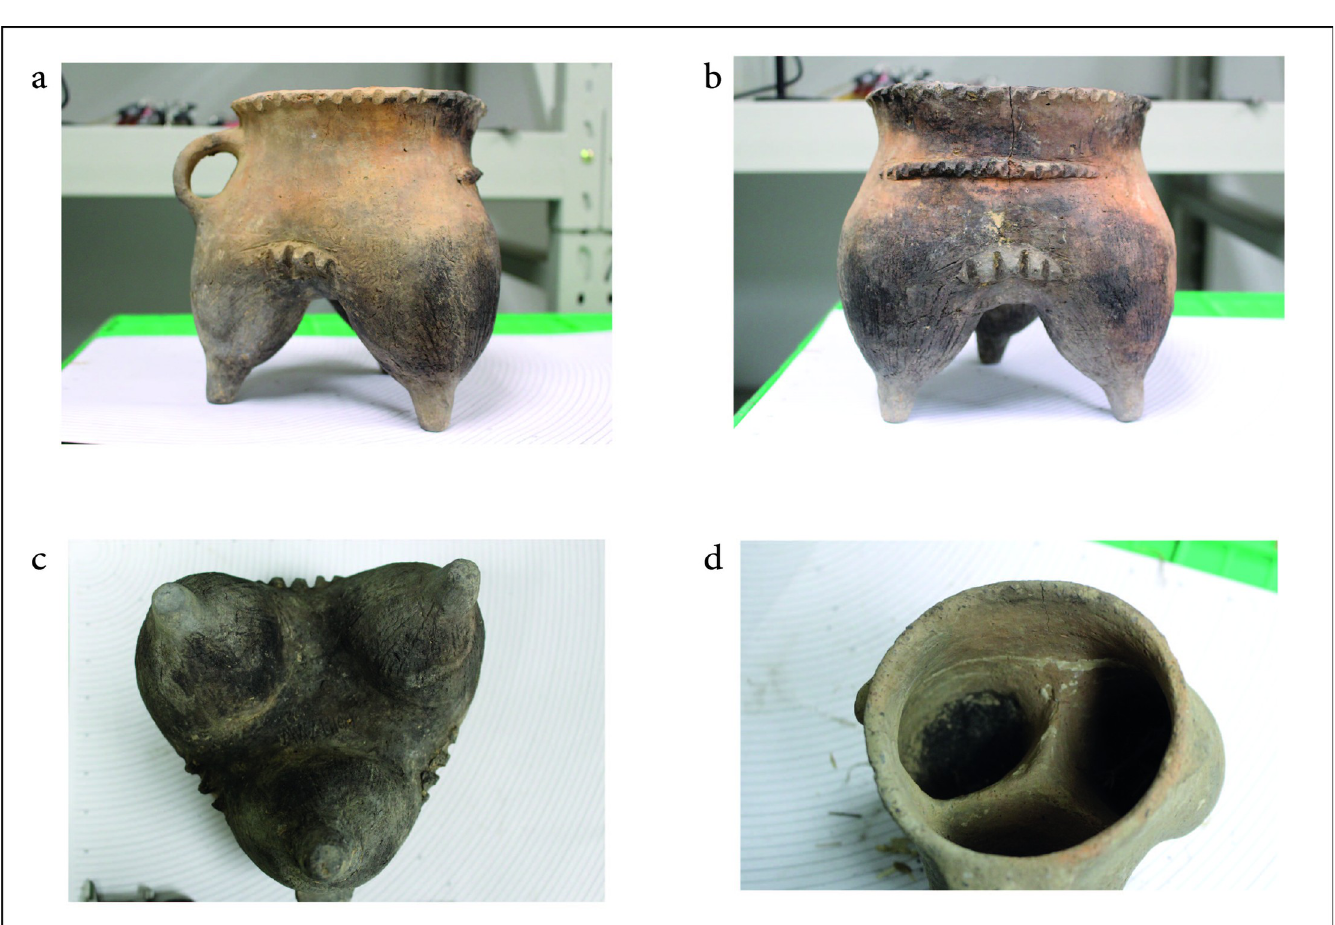
Fig 5. Use-wear alteration marks of Zhanqi li vessels. A. Soot remains extending from the belly down to the foot. B. Soot remains on the handle perpendicular to the side exposed to the fire. C. Heavy sooting on the base and oxidation on the feet (nipple), indicating placement base side down in the fire. D. Heavy carbonization can be seen in each of the tripod’s three feet, an expected outcome of a cooking vessel placed in the fire or exposed to a fire source base side down from which enough liquid evaporated to allow food particles to burn and